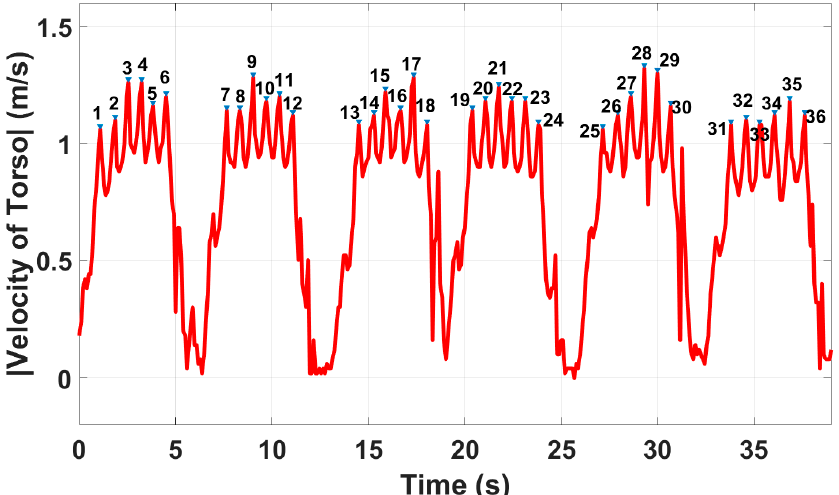
Table 2. Extracted gait values in a hallway.